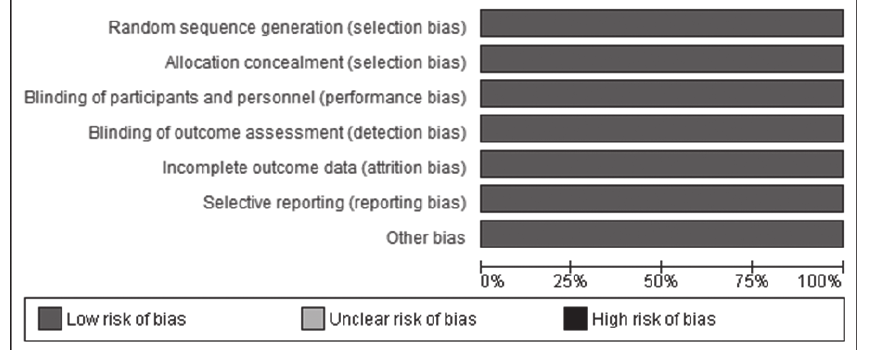
Figure 2 - Forest Plot showing the meta-analysis of uses of Topical 5% Acyclovir–1% Hydrocortisone Cream (ME-609) versus placebo for the treatment of Herpes